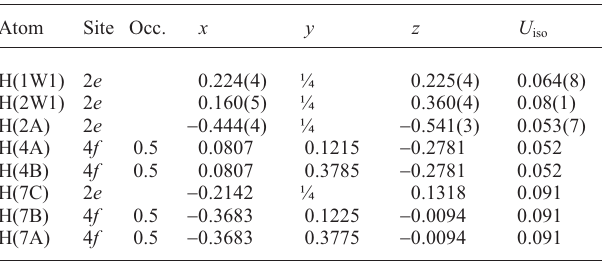
Table 2. Atomic coordinates and displacement parameters (in Å 2 )